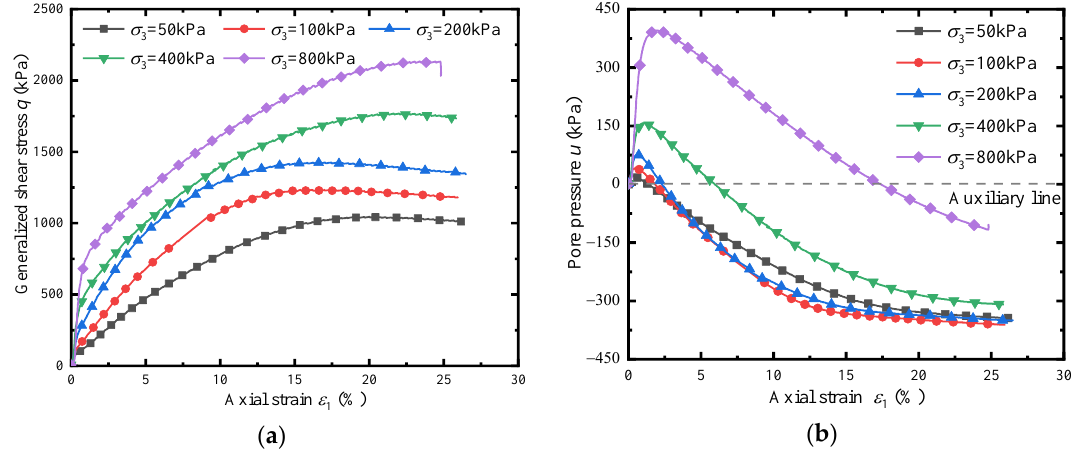
Figure 5. Relationships between stress and pore pressure with axial strain under undrained condi- tions. ( a ) Stress-strain relationships. ( b ) Pore pressure-strain relationships.